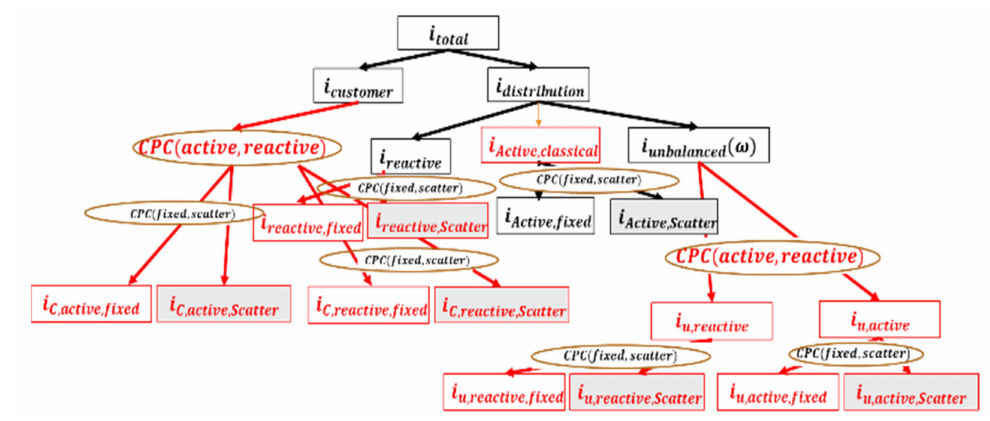
Figure 5. Reoperation of CPC as {active, reactive} and {fixed,